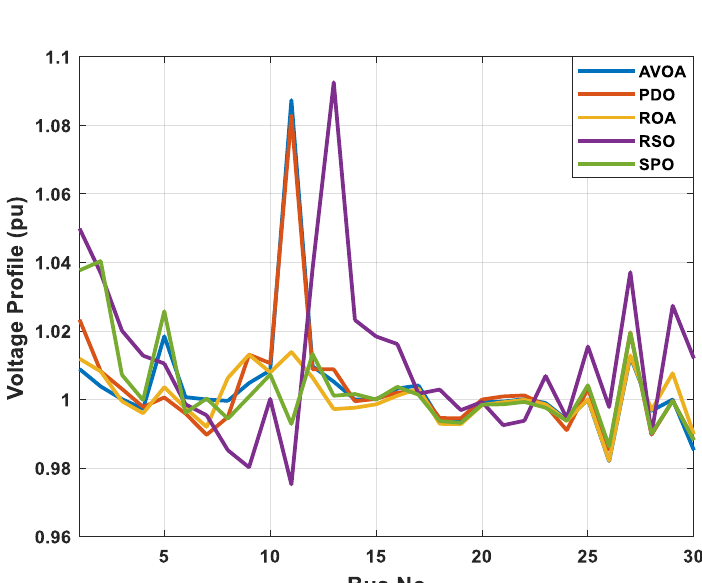
Figure 3. The AVOA voltage profile with the other compared methods for case 1.